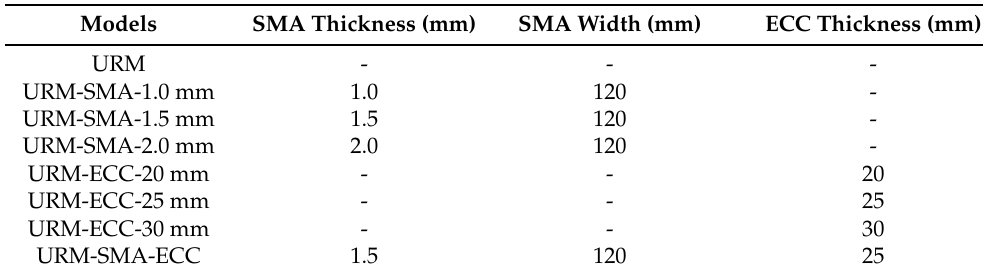
Table 2. Geometrical information of URM